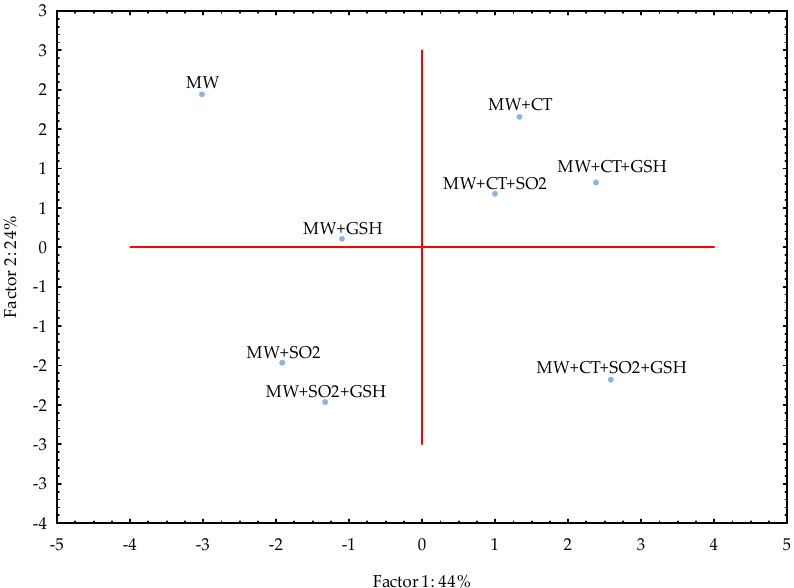
Figure 2. Principal Component Analysis (PCA) for the model wine solution (MW) stored in the dark after the light exposure. For samples coding refer to Table 6. Legend: SO 2 , sulfur dioxide (20 mg/L), GSH, glutathione (50 mg/L), CT, chestnut tannins (50 mg/L). PC1 and PC2 together explained 64% of the variance for WW samples that resulted clustered as follows: (i) WW, (ii) WW+SO 2 , (iii) WW+CT, WW+CT+SO 2 , WW+GSH, (iv) WW+SO 2 +GSH, WW+CT+GSH and (v) WW+CT+SO 2 +GSH (Figure 3). It appears